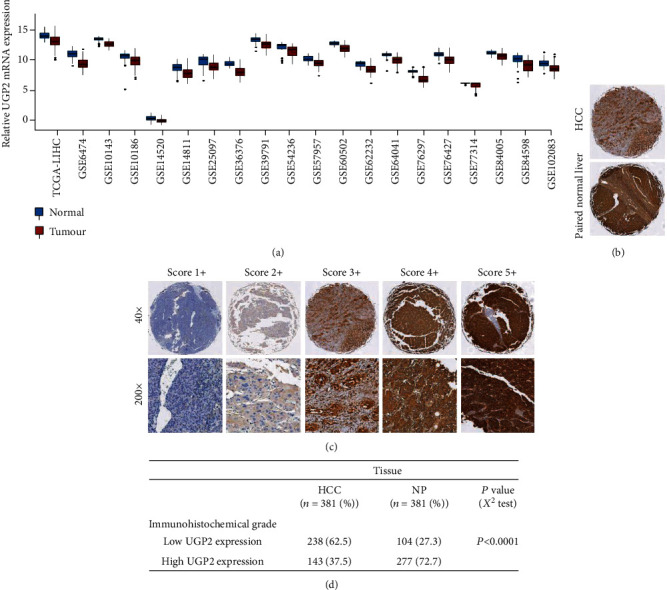
UGP2 mRNA levels and protein expression are significantly downregulated in HCC. (a) The UGP2 expression level was significantly lower in HCC tissues than in adjacent nontumour tissues in the TCGA cohort and GEO datasets. (b) A representative IHC image of UGP2 expression in HCC and normal tissues. (c) Representative images of UGP2 staining in HCC tissues. (d) The UGP2 expression level in HCC tissues was lower than that in paired nontumour tissues in the ZZU HCC cohort. UGP2: uridine diphosphate-glucose pyrophosphorylase 2; TCGA: The Cancer Genome Atlas; HCC: hepatocellular carcinoma; GEO: Gene Expression Omnibus; IHC: immunohistochemistry.